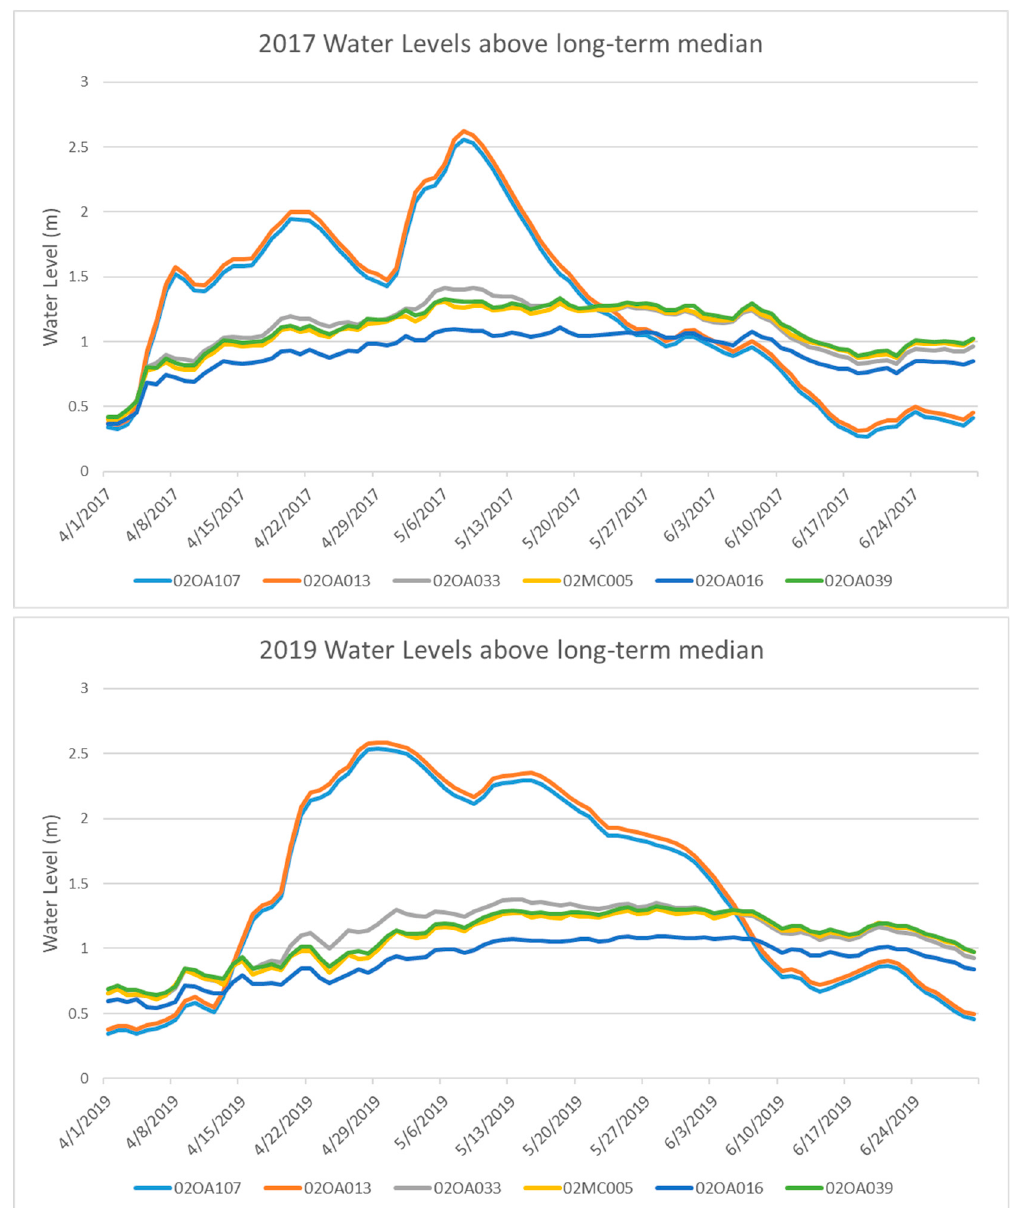
Figure 2. Hydrometric water levels above long-term medians for six stations located east and south of the Island of Montreal on the Lake of Two Mountains (02OA107 and 02OA013), Lake St-Louis (02OA016 and 02OA039) and the St-Lawrence River (02OA033 and 02MC005) for the spring of 2017 ( top ) and 2019 ( bottom ).